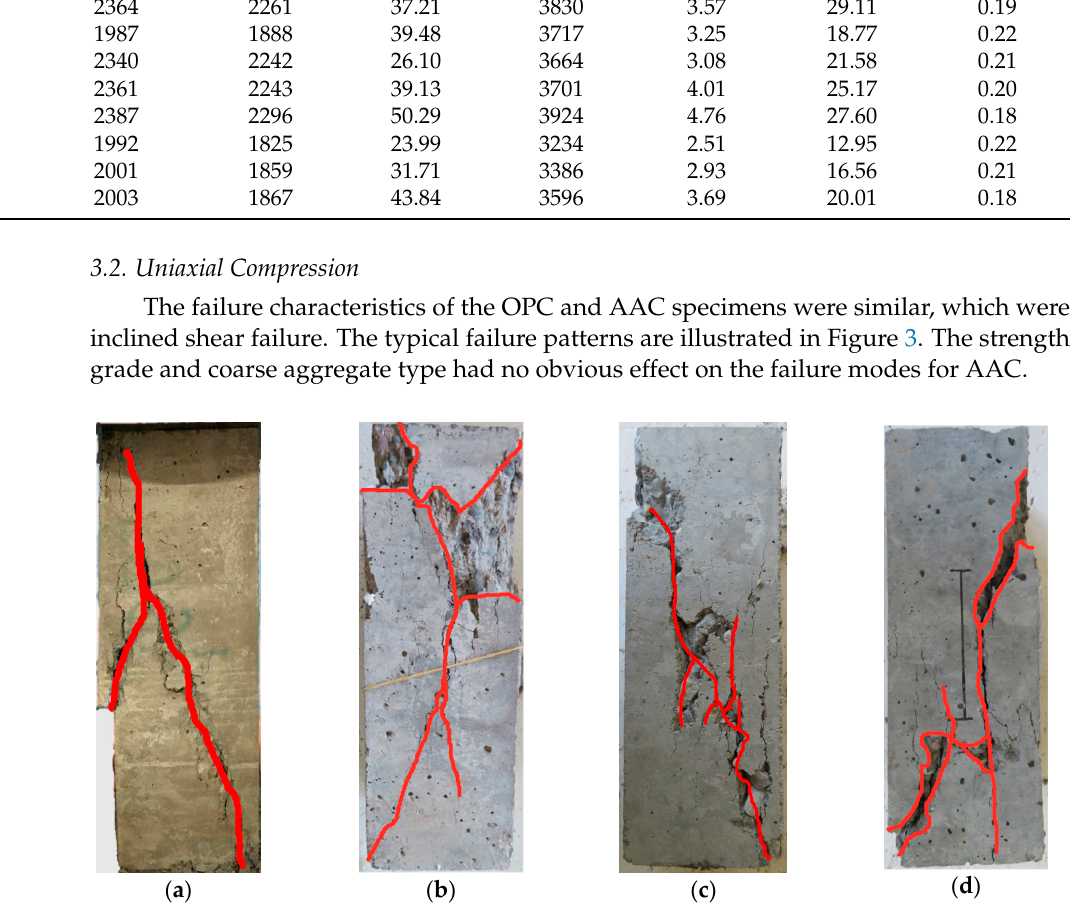
Table 5. Basic properties of the mixtures.